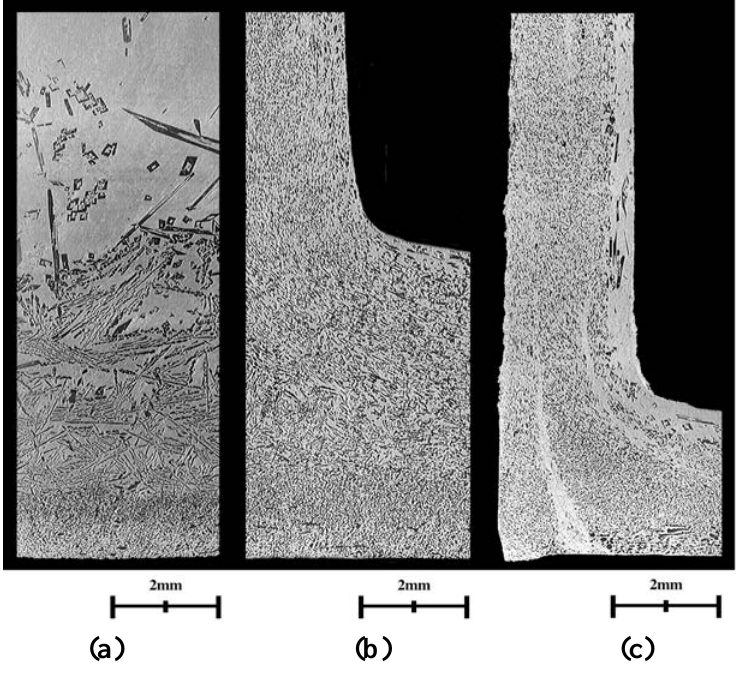
Figure 9. Higher magnification views showing the profile of the